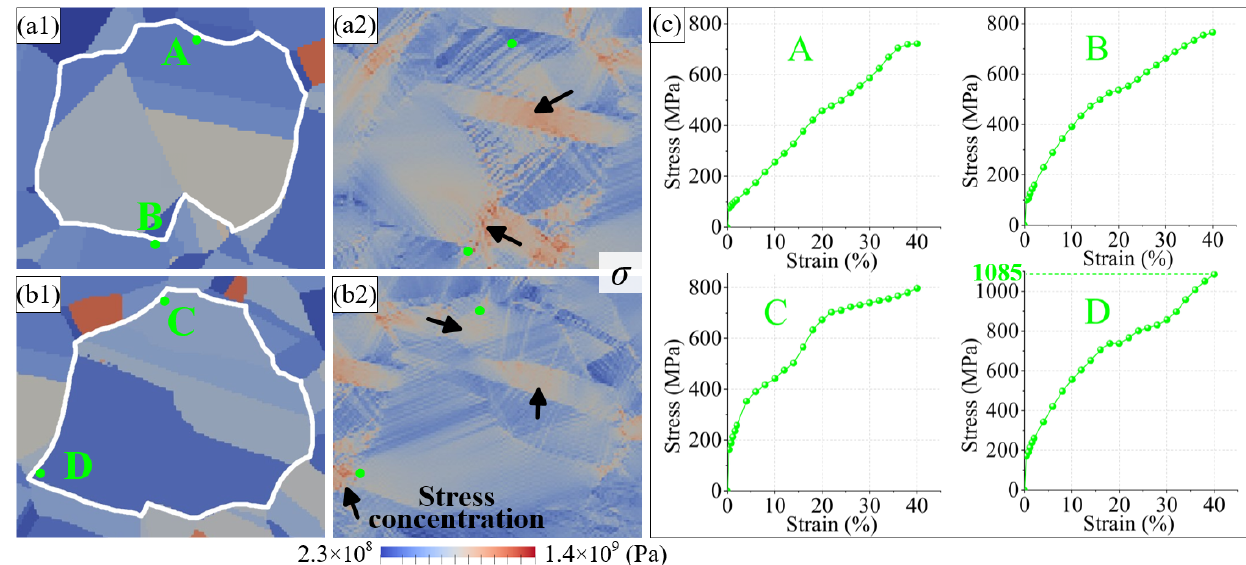
Figure 8. The ( a1 ) position of points near random boundaries at initial simulation state and ( a2 ) stress distribution at final simulation state in grain group GG Ⅰ . The ( b1 ) position of points near random boundaries at initial simulation state and ( b2 ) stress distribution at final simulation state in grain group GG Ⅱ . ( c ) The stress variation of points A–D.